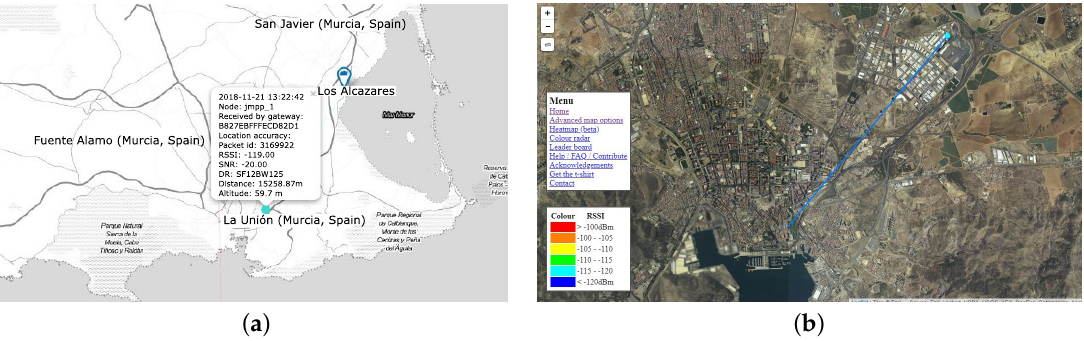
Figure 8. Coverage testing analysis. ( a ) Gateway identification map. ( b ) Coverage testing results on The Things Network (TTN) Mapper